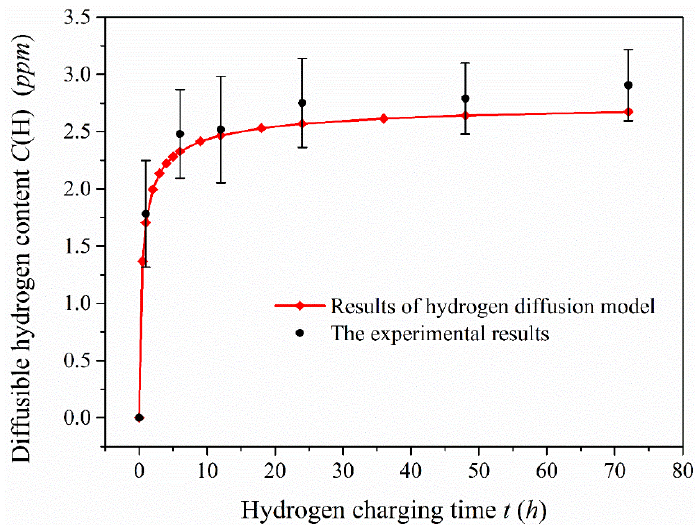
Figure 8. Comparison of diffusible hydrogen content measured in the 1-mm-thick specimen after charging and analytical results under the hydrogen diffusion model.